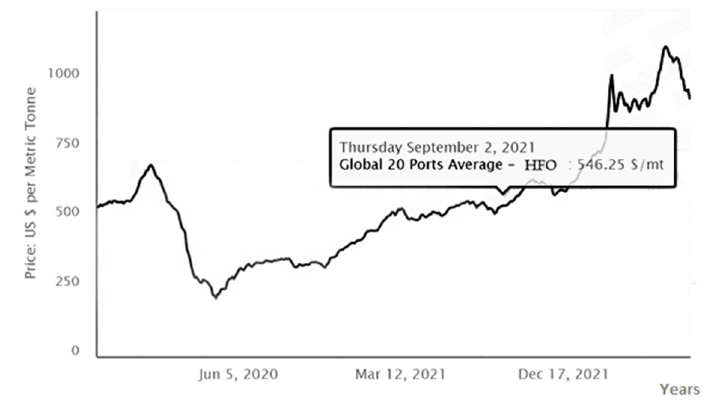
Figure 11. HFO price trend from January 2020 to July 2022.